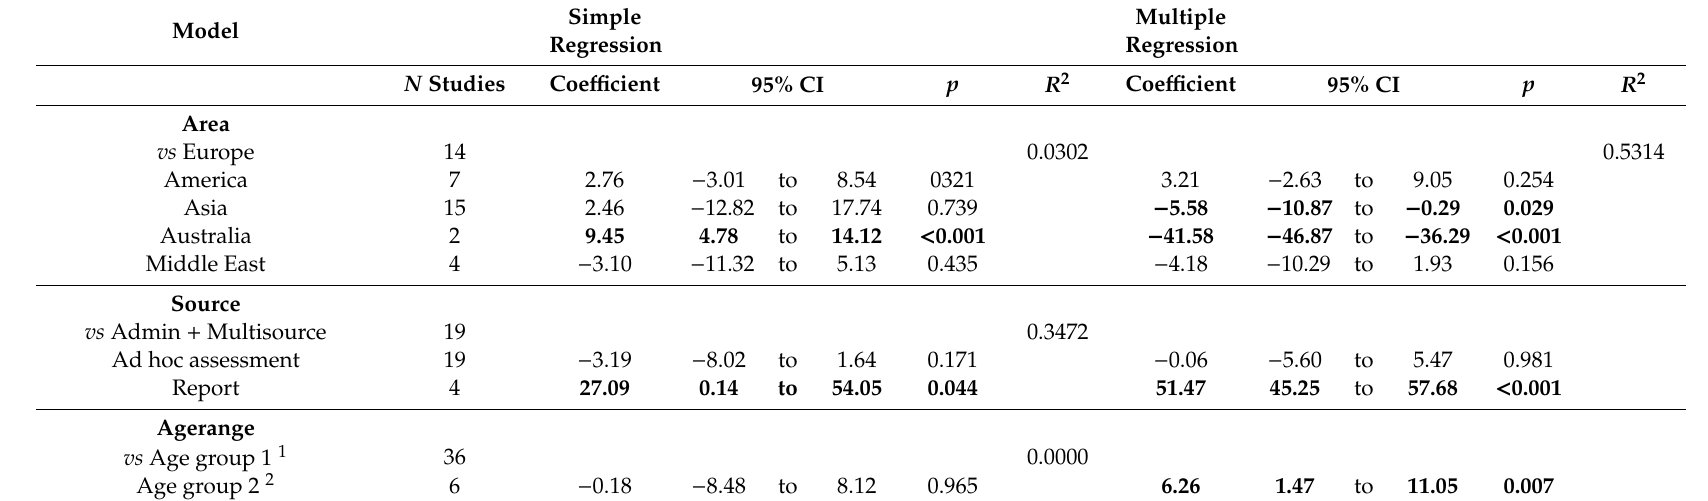
Table 8. Results of simple and multiple regression analyses performed on the selection of studies ( n = 42) listed in Tables 2–4.